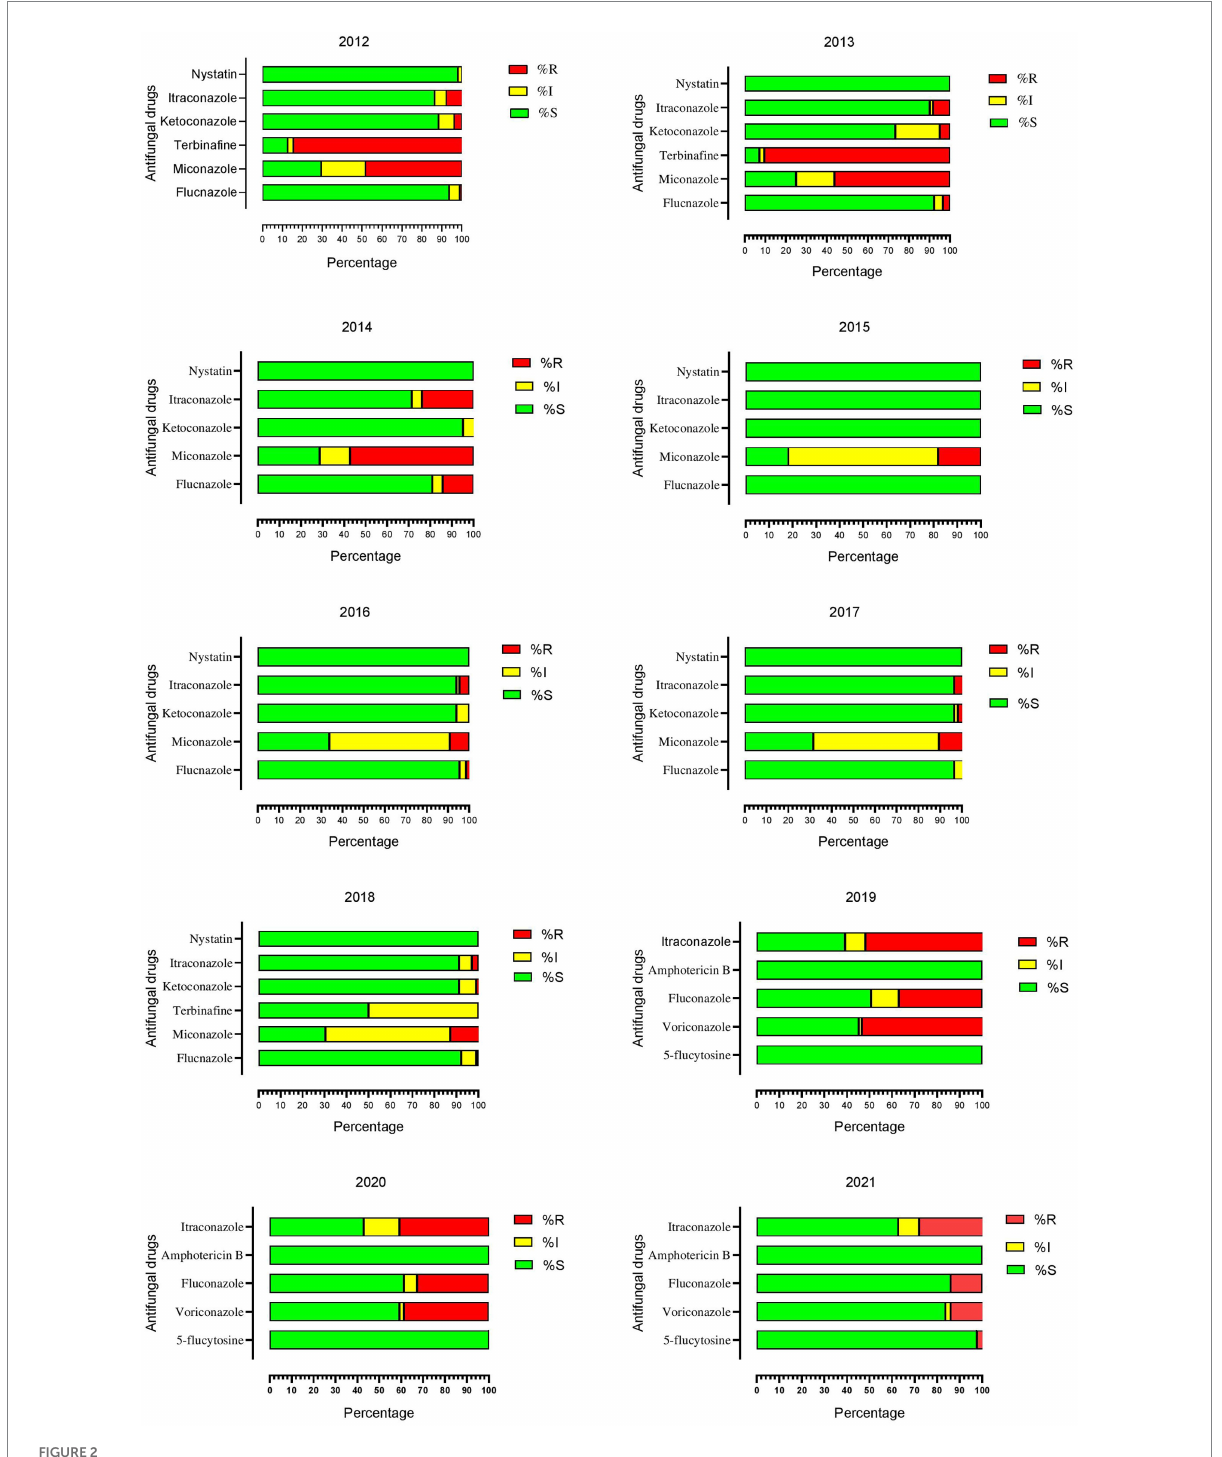
FIGURE 2 Year-wise antifungal susceptibility patterns of Candida albicans against all tested